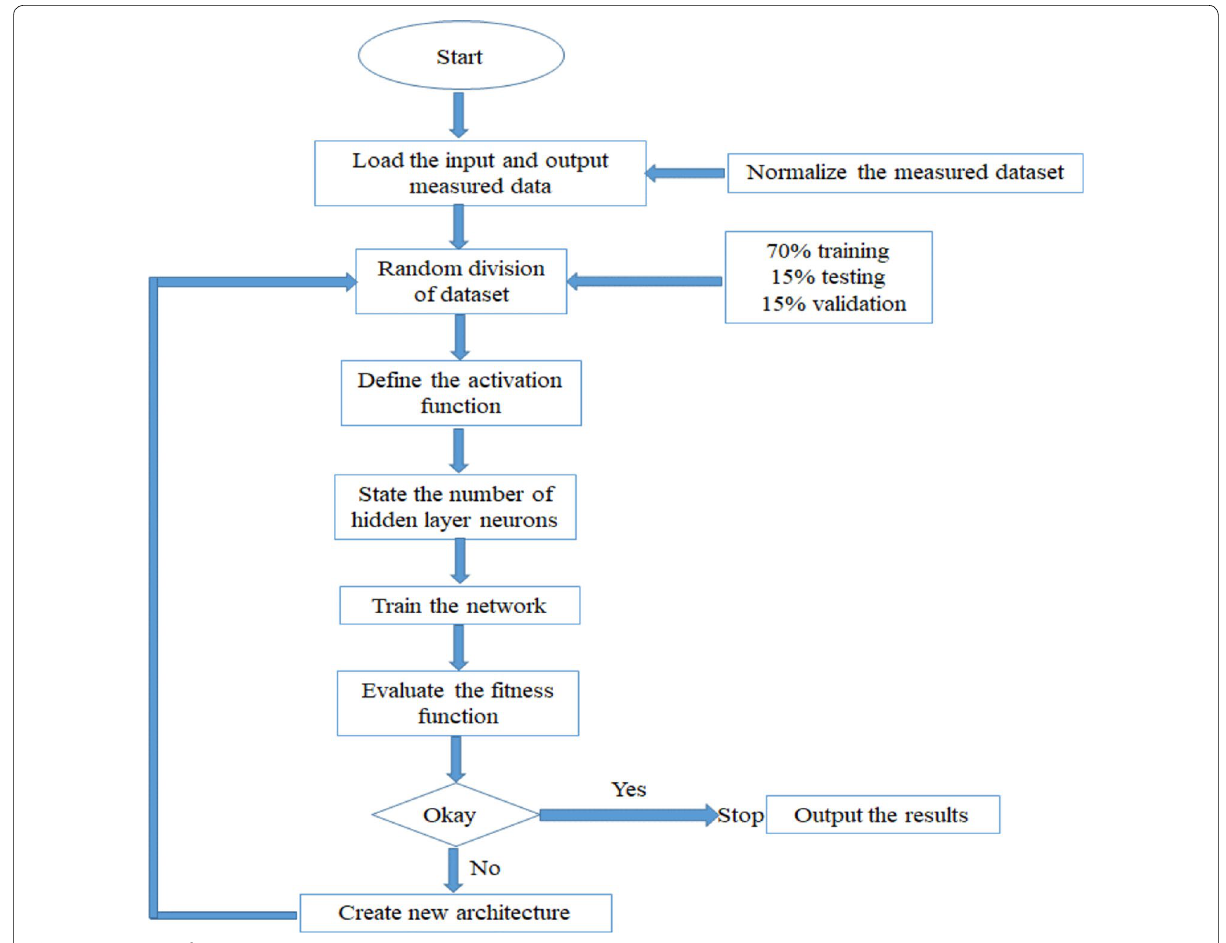
Fig. 2 Basic steps of ANN